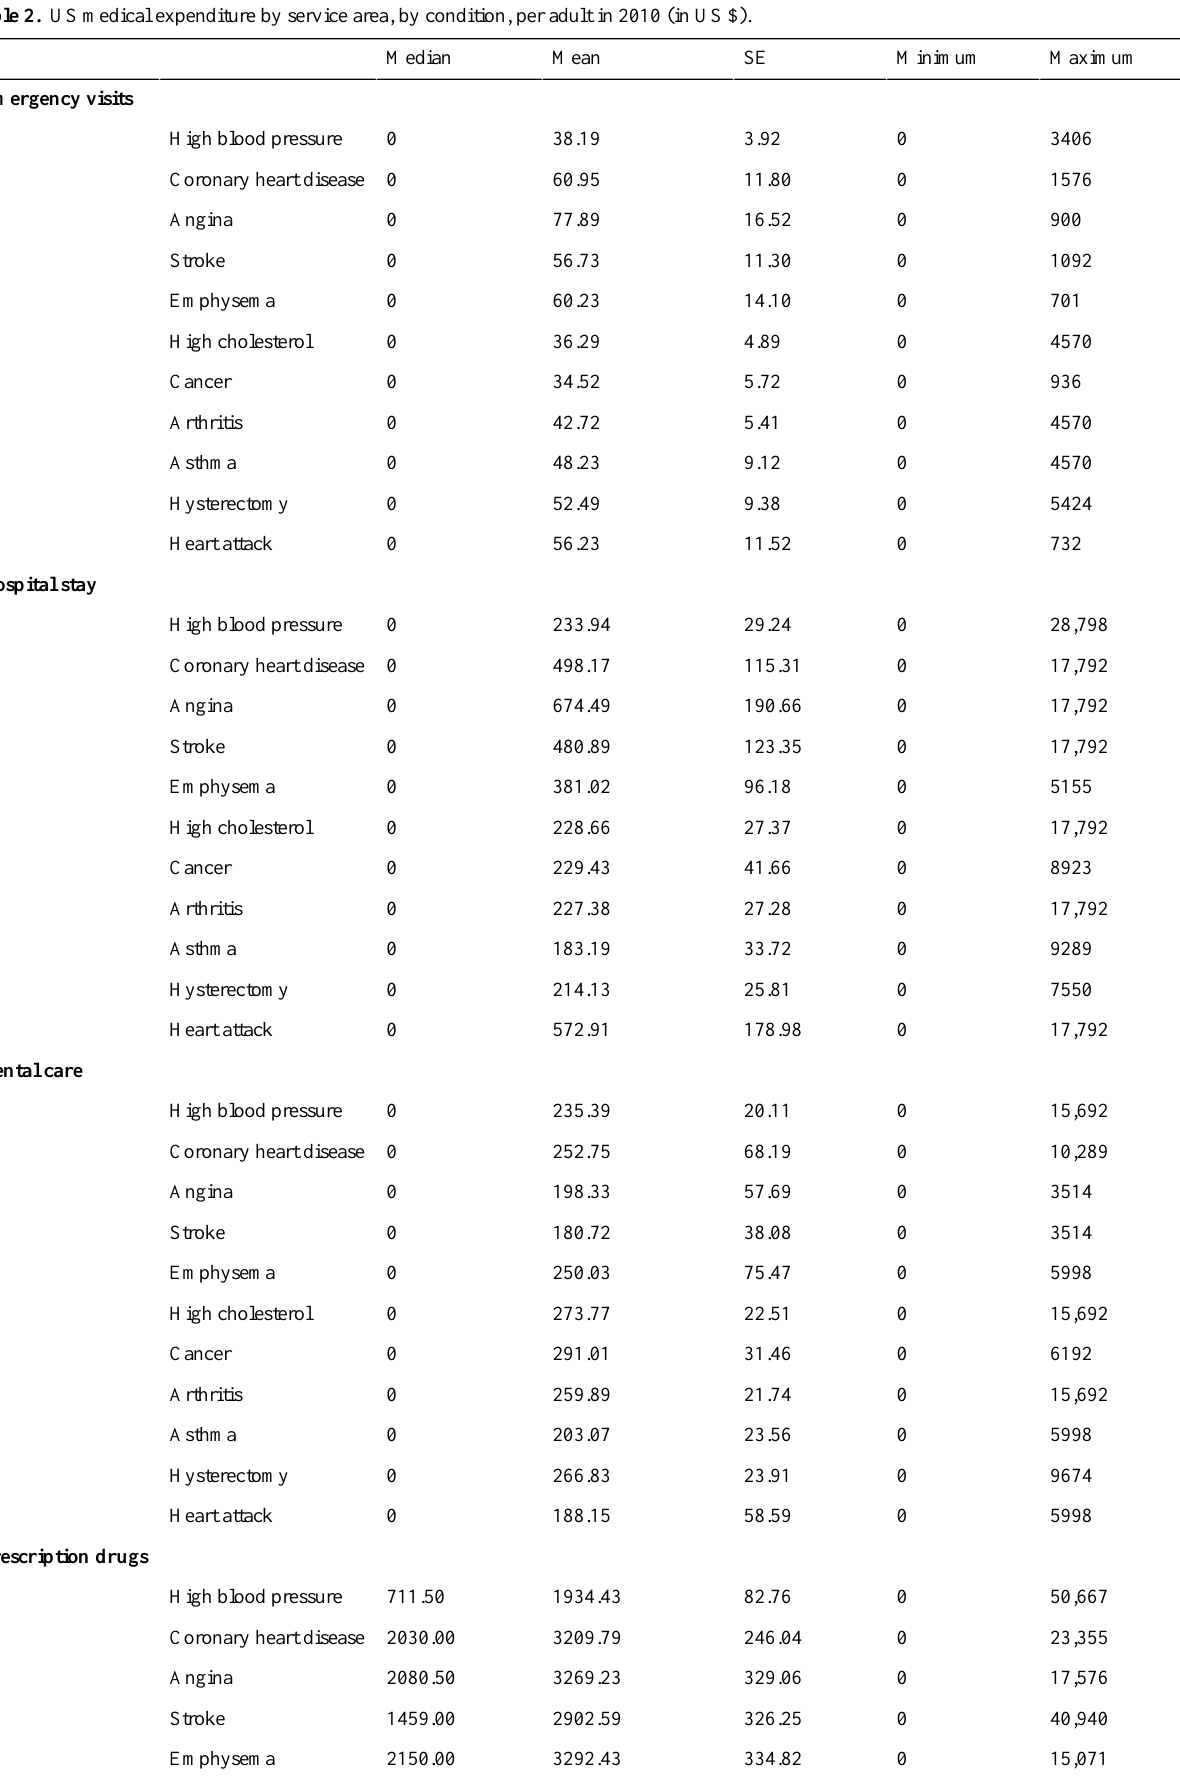
Table 2. US medical expenditure by service area, by condition, per adult in 2010 (in US